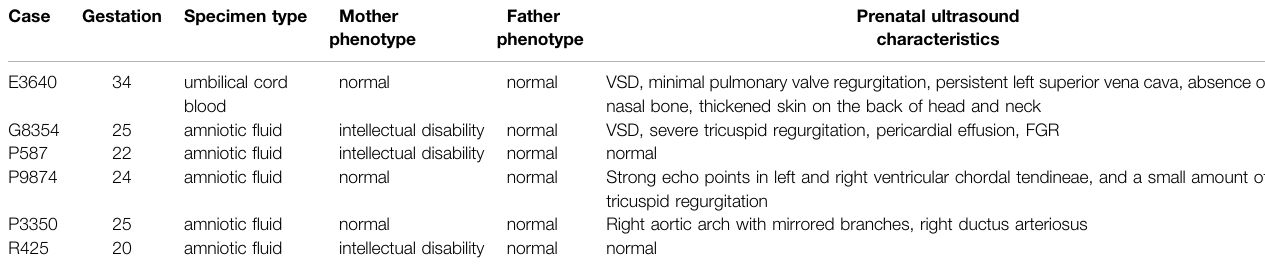
TABLE 1 | Clinical information and prenatal ultrasound phenotypes of the six fetuses.